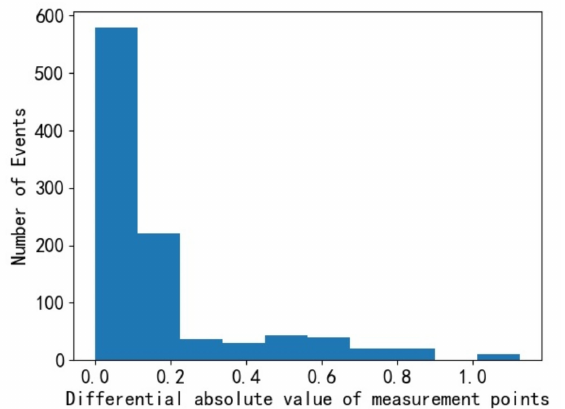
Figure 6. Frequency histogram distribution of the absolute value of the first-order forward difference. For the anomalous data of the current signal, the specific process of filling in the missing data and rejecting the anomalous fluctuation data based on the first-order forward differencing method is as